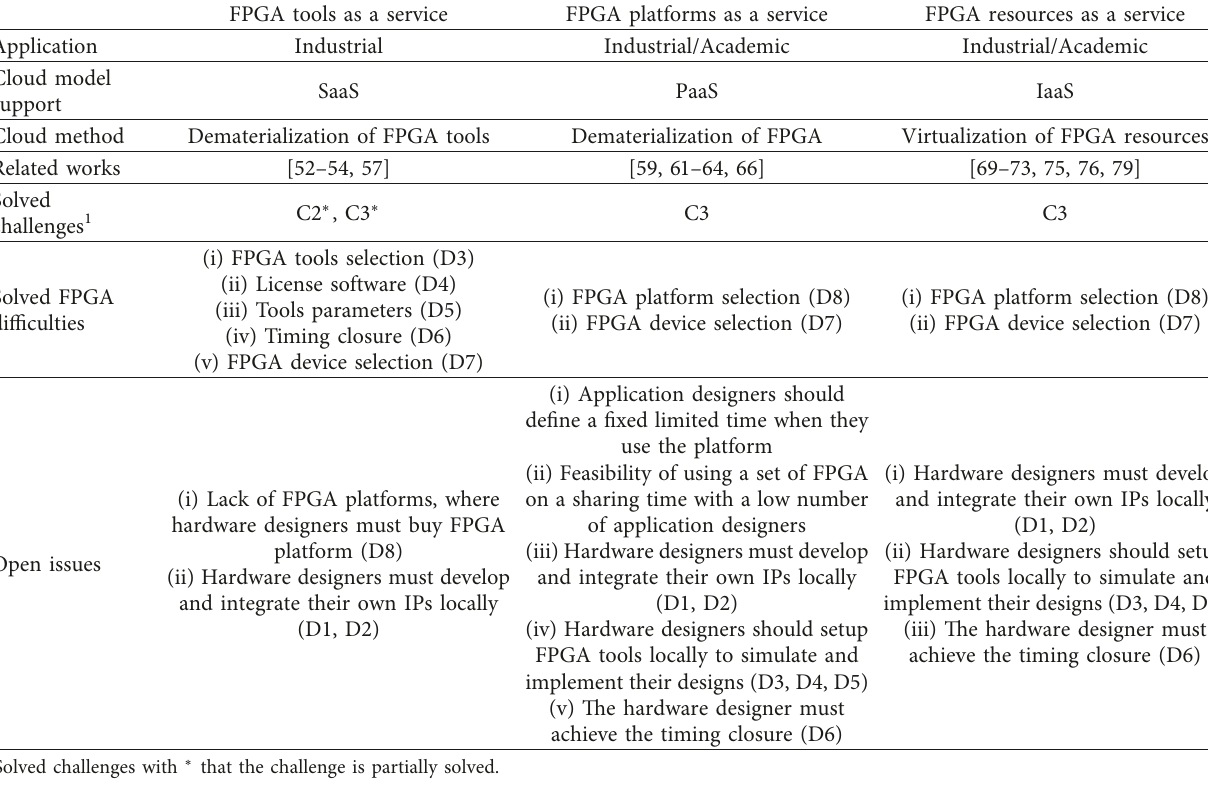
Table 6: Summary of the FPGA cloud services.